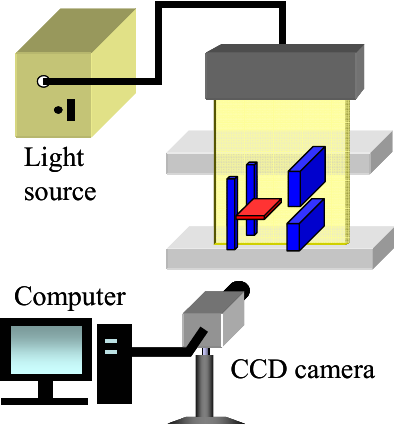
Fig.3 Schematic of experimental apparatus for flow